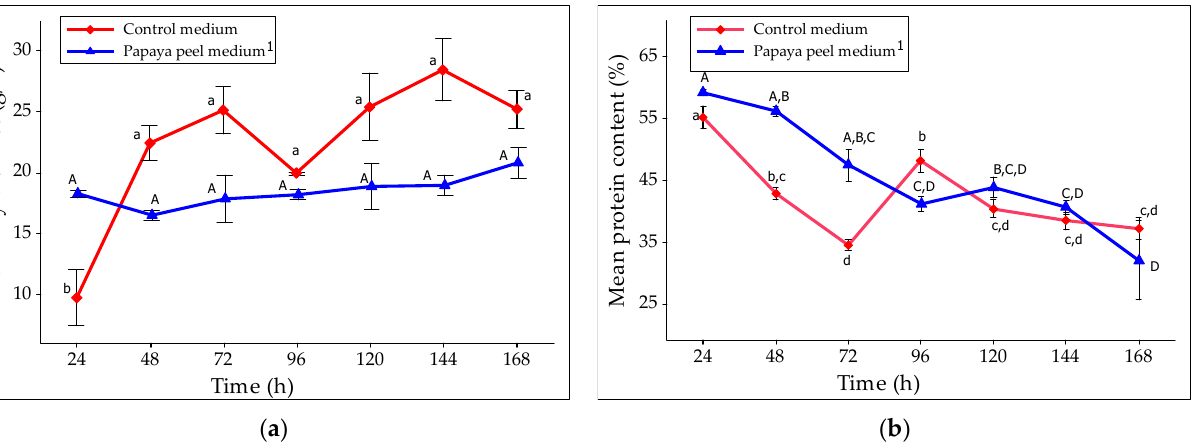
Figure 4. Effect of fermentation time on the dry biomass and protein content of SCP produced from papaya peel and control media using a mixed culture of palmyrah toddy in liquid state fermentation at 100 rpm with 10% ( v / v ) substrate concentration at pH 5.0 and 25 °C: ( a ) effect of fermentation time on dry biomass; ( b ) effect of fermentation time on the protein content. Comparisons of mean were performed with Tukey’s multiple comparison test at p < 0.05. Different uppercase and lowercase letters indicate the significant differences in papaya peel medium and control medium, respectively 1